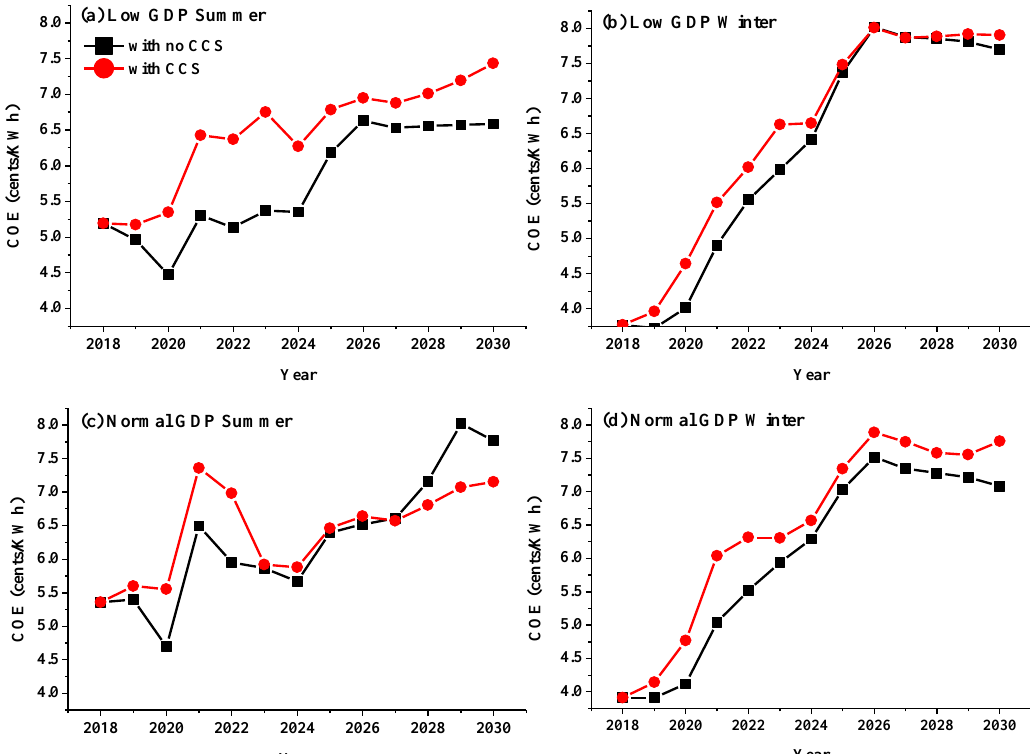
Figure 12. Cost of electricity under the CCS case (with CCS) and reference case (with no CCS).